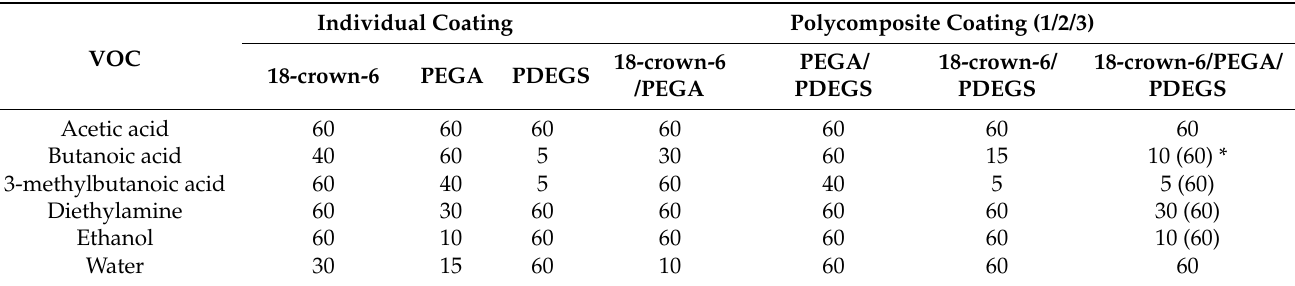
Table 9. Time to reach the maximum signal ( τ max , s) with individual coatings and polycomposite coatings upon sorption of vapors of